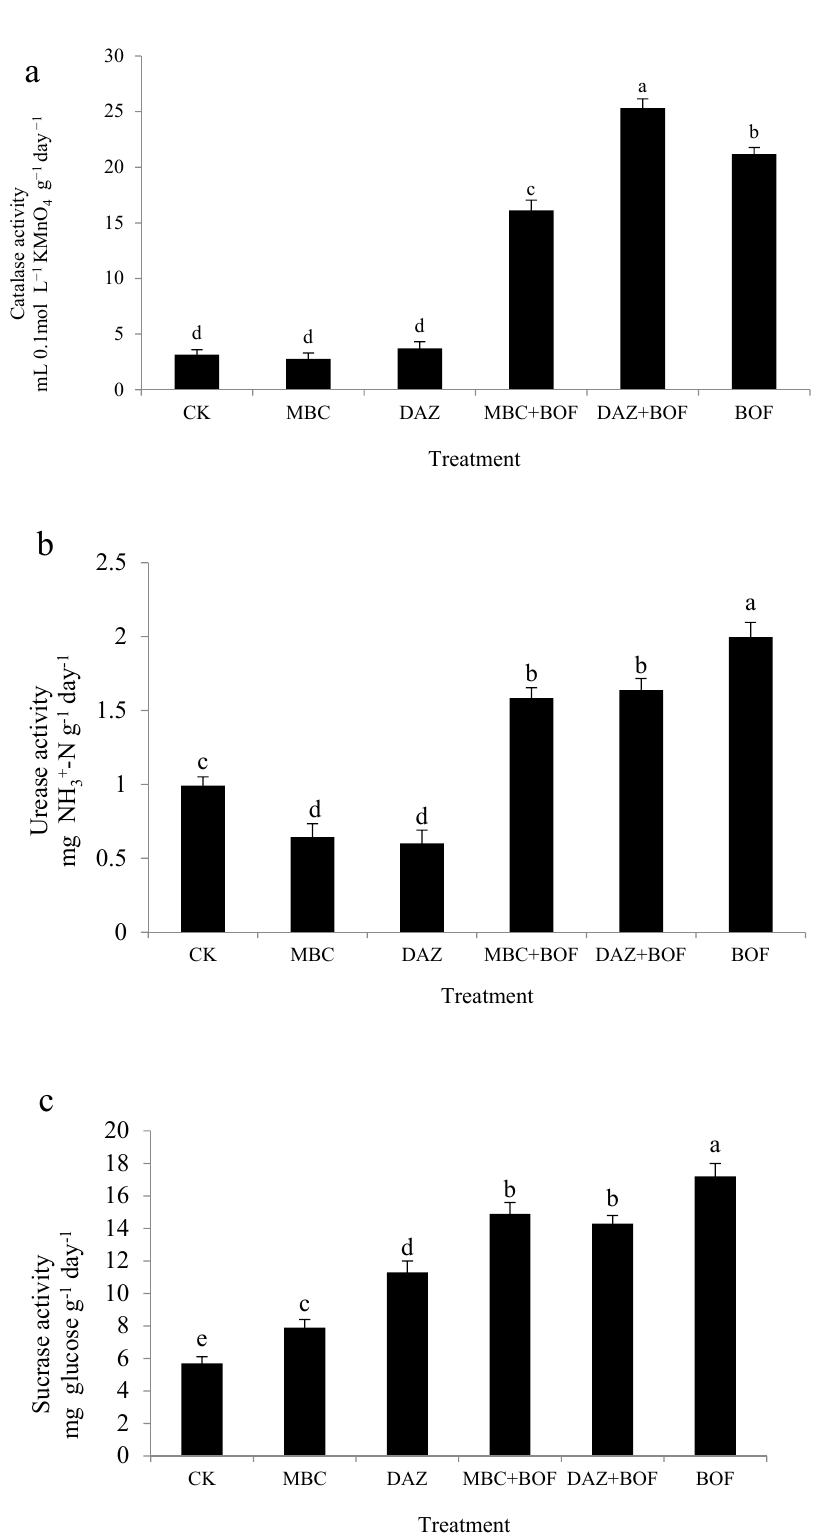
Figure 2. Enzyme activity: ( a ) Catalase; ( b ) Urease; and ( c ) Sucrose in soils sampled from plants experiencing the range of treatments. The bars represent the mean and the whiskers the standard deviation. See footnote to Table 1 for the treatment codes. Letters above the bars indicate a significant difference according to Duncan’s multiple range test at p < 0.05 level.